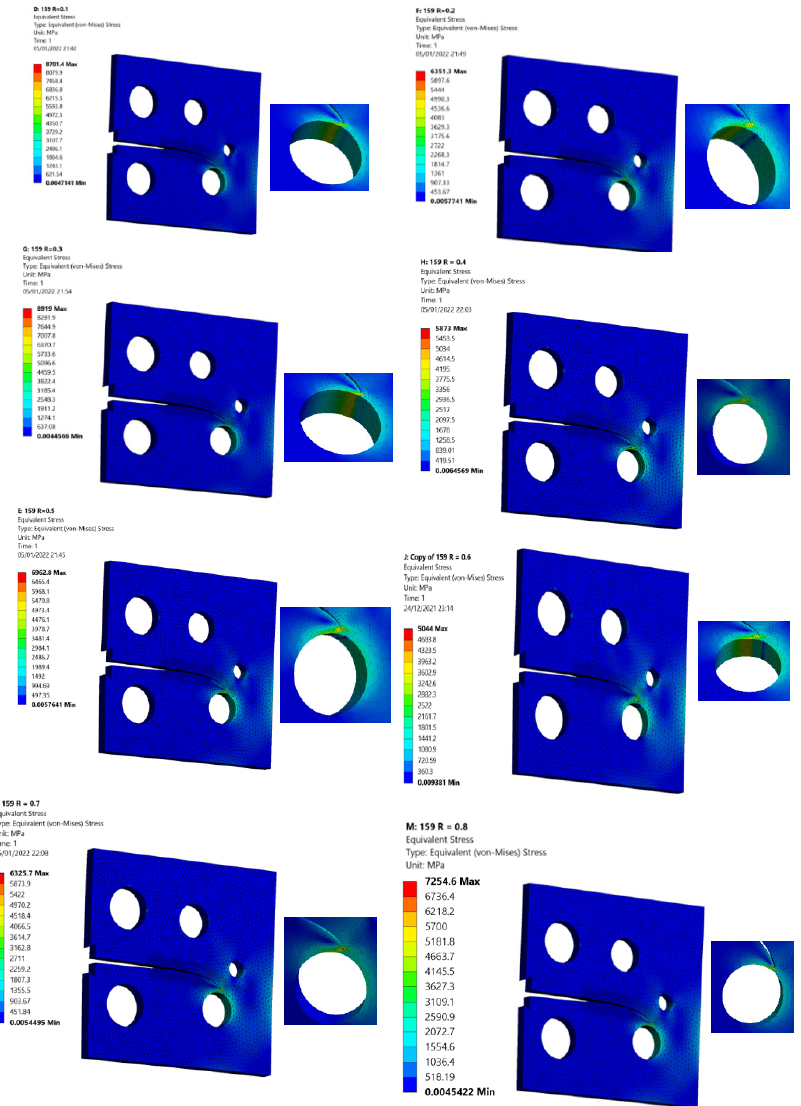
Figure 15. Von Mises stresses distribution for specimen 3 with various stress ratios, R = 0.1–0.8.